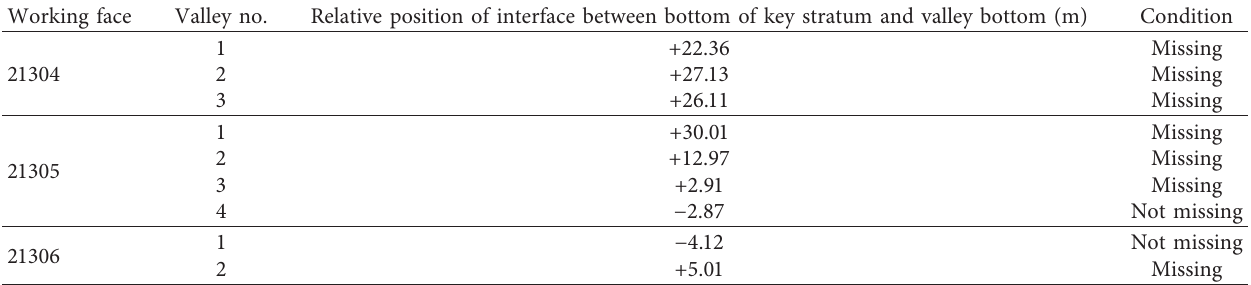
Table 2: Missing statistics of the main key stratum in the overlying strata of the No. 3 Panel from the Huojitu Coal Mine. Working face Valley